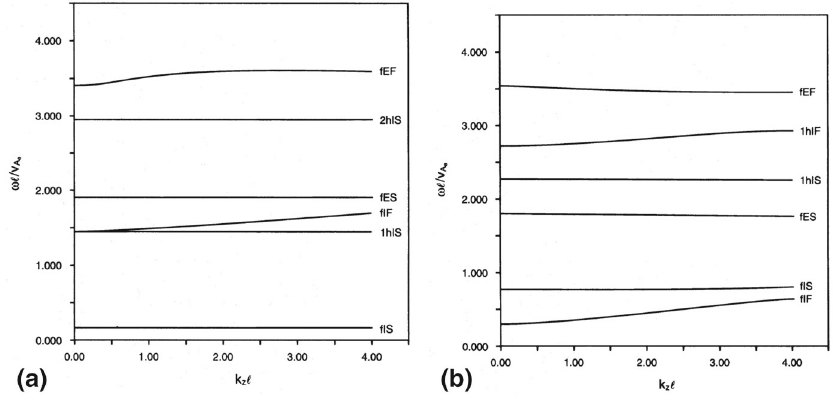
Fig. 38 Dispersion diagram of magnetoacoustic a kink modes and b sausage modes in the equilibrium model represented in Fig. 37. Meaning of labels at the right of each curve: modes are identified as funda- mental (f), first harmonic (1h), second harmonic (2h), …; internal or external (I or E); and fast or slow (F or S). Here ω and k z are the frequency and the wavenumber along the slab, while v Ae is the coronal Alfvén speedand L (denotedby (cid:13) intheseplots)ishalfthelengthofthesupportingmagneticfield.Parametervalues used: v Ap = 28 km s − 1 , c sp = 15 km s − 1 , v Ac = 315 km s − 1 , c sc = 166 km s − 1 . Image reproduced with permission from Joarder and Roberts (1992b), copyright by ESO